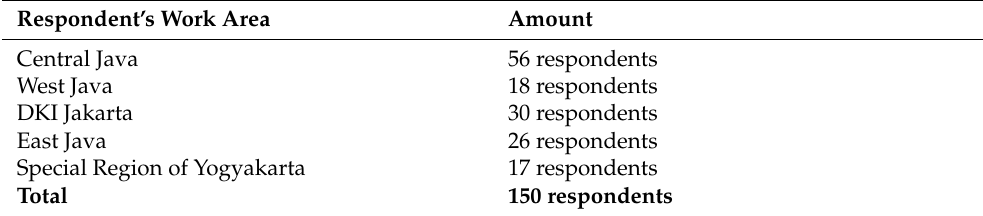
Table 2. Distribution of respondents’